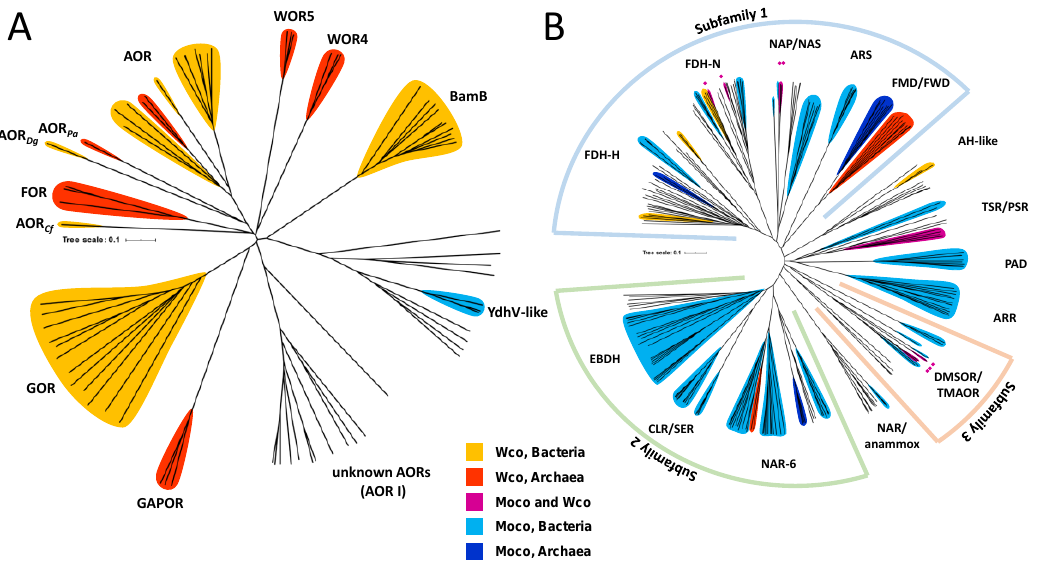
Figure 3. Phylogenetic trees of the large subunits of selected enzymes of the AOR family ( A ) and the DMSOR family ( B ). Clades or subclades containing tungsten enzymes are labeled in light-orange (bacteria), dark-orange (archaea) or violet (enzymes working with either tungsten or molybdenum, for better visualization additionally marked with a violet dot), and those containing molybdenum enzymes are labeled in light- or dark-blue (bacterial and archaeal enzymes, respectively). Enzyme clades of unknown metal content are not colored. Members of the DMSOR subfamilies 1–3 are highlighted by the outer circle as indicated. Species epithets for unaffiliated AORs: Pa: Pyrobaculum aerophilum ; Dg: Desulfovibrio gigas ; Cf: Clostridium formicoaceticum . Abbreviations: AOR, FOR, GAPOR, WOR5: archaeal aldehyde oxidoreductases of various specificities (for details see text); BamB: active site subunit of class II benzoyl-CoA reductases; WOR4, YdhV, AOR1: archaeal or bacterial Mo- or W-containing enzymes of unknown function; GOR: glyceraldehyde-3-phosphate oxidoreductases from thermophilic bacteria; FDH: formate dehydrogenases; NAP/NAS: periplasmic and assimilatory nitrate reductases; FMD / FWD: molybdenum- and tungsten-dependent formylmethanofuran dehydrogenases; AH-like: acetylene hydratases and similar hypothetical enzymes; TSR/PSR: thiosulfate/polysulfide reductases; PAD: phenylacetyl-CoA dehydrogenases; ARR, ARS: arsenate reductases/arsenite oxidases; DMSOR: dimethyl sulfoxide reductases; TMAOR: trimethylaminoxide reductases; NAR/anammox: chemolithotrophic nitrite oxidoreductases and putative nitrate reductases from anammox bacteria; NAR-6: nitrate reductases and similar clades; CLR/SER: chlorate/selenate reductases and dimethyl sulfide dehydrogenases; EBDH: ethylbenzene dehydrogenases and related enzymes.